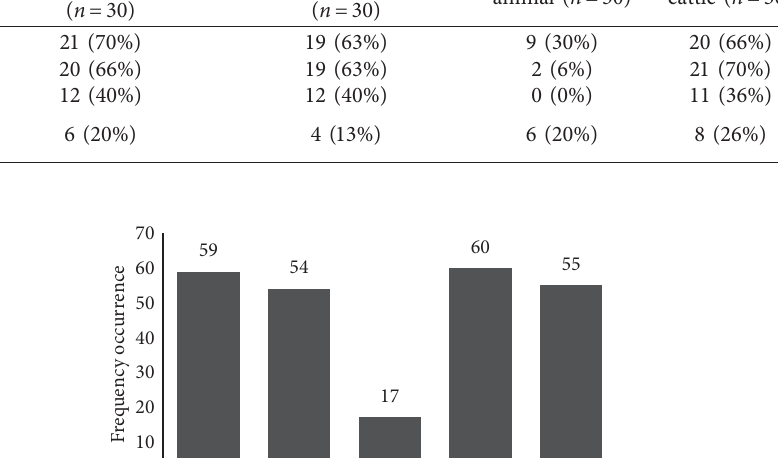
Table 1: Occurrence of isolates bacteria across critical sampling points ( n � 150) of different samples collected from dairy farm animals. No. of positive samples (%) Bacteria Isolate no. Milk samples, fore and Milk samples, fore and isolated (%) hinds teats, cattle hinds teats, buffaloes